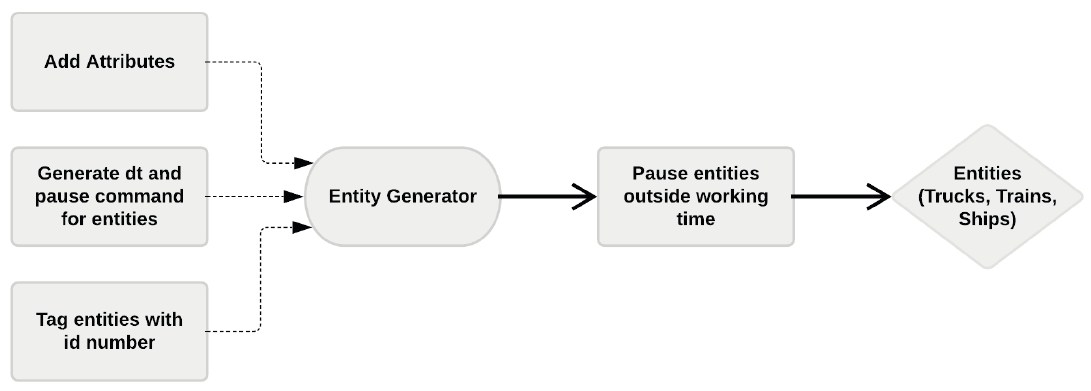
Figure 5. After an entity has been selected (see Figure 4), the remaining of the operation is to define its attribute (volume of logs), and an id tag to differentiate them throughout the simulation